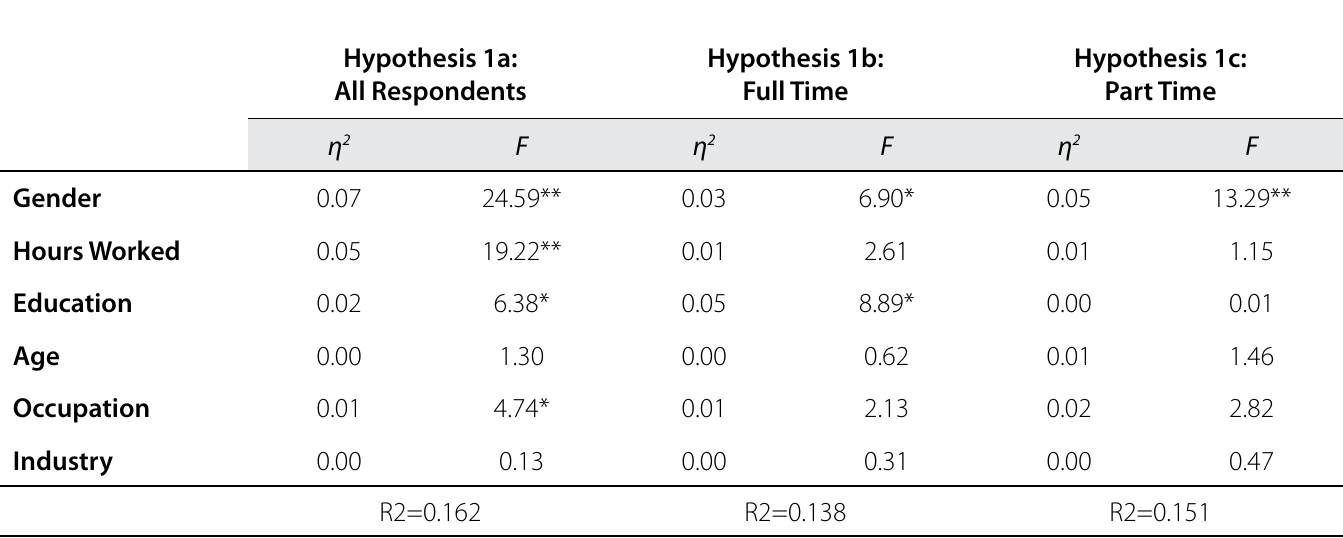
Table 2b. Multivariate GLM Analysis of Earnings by Gender Hypothesis 1a: Hypothesis 1b: